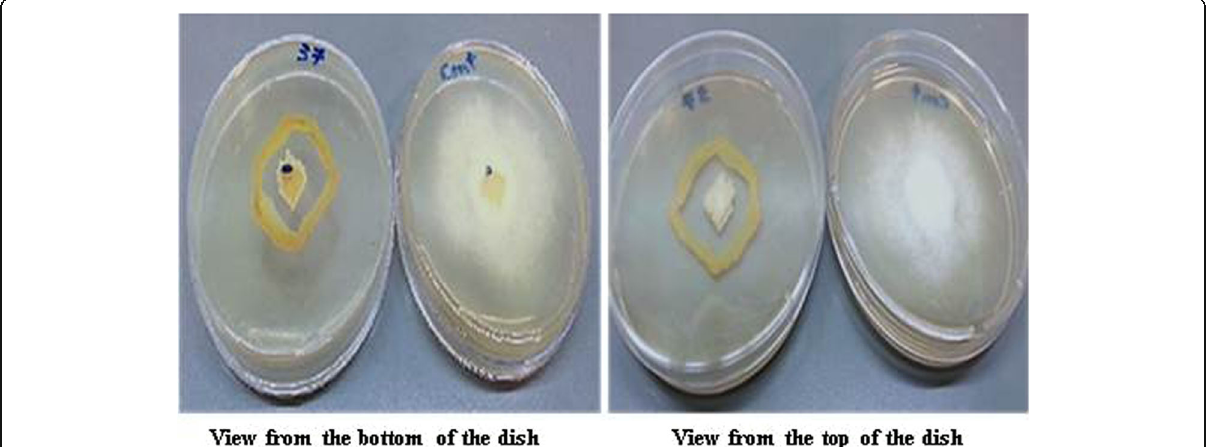
Fig. 9 The growth of treated Phytophthora nicotianae by Lysobacter enzymogenes BB14 compared to that of untreated fungus on V8 media (10%)